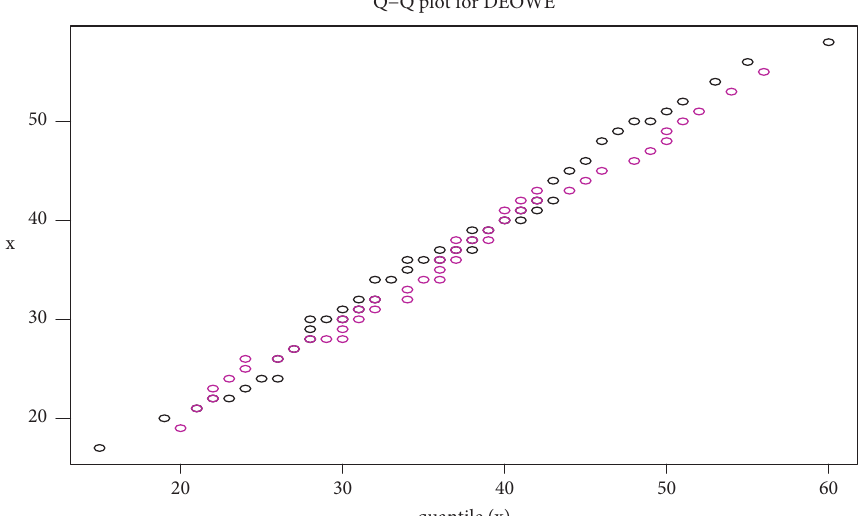
Figure 11: Graphical plots of the data and the quantile function as a function of ( x ), where x is the number of deaths per day.